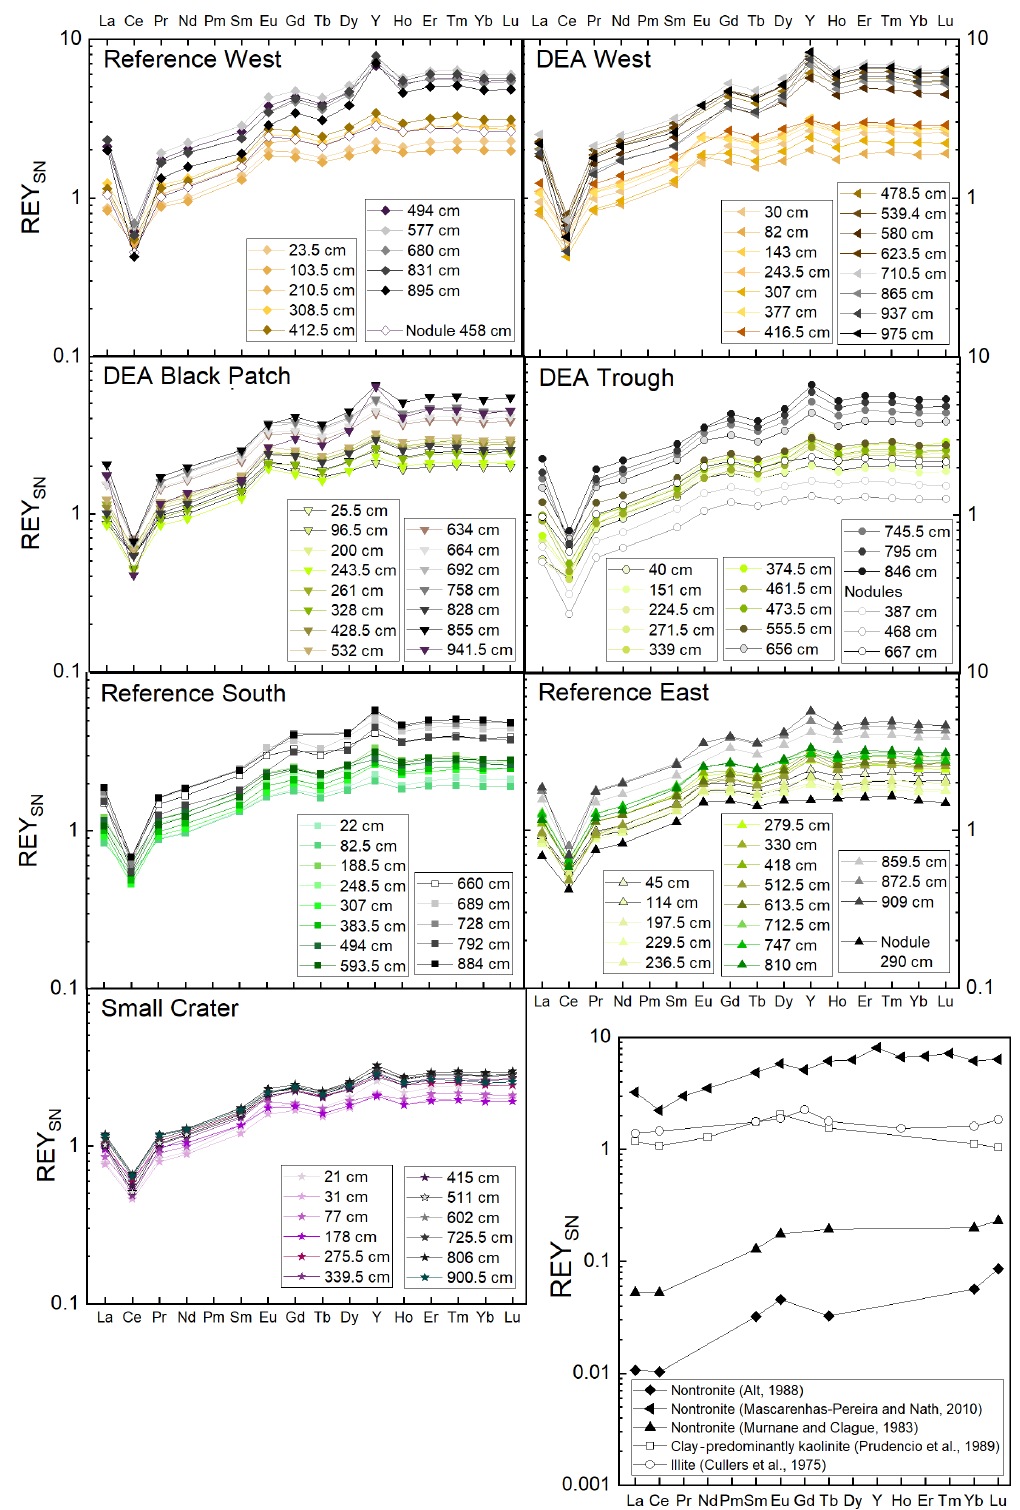
Figure 9. REY SN patterns of the seven cores from this study and for the clay minerals nontronite, illite, and kaolinite from the literature for